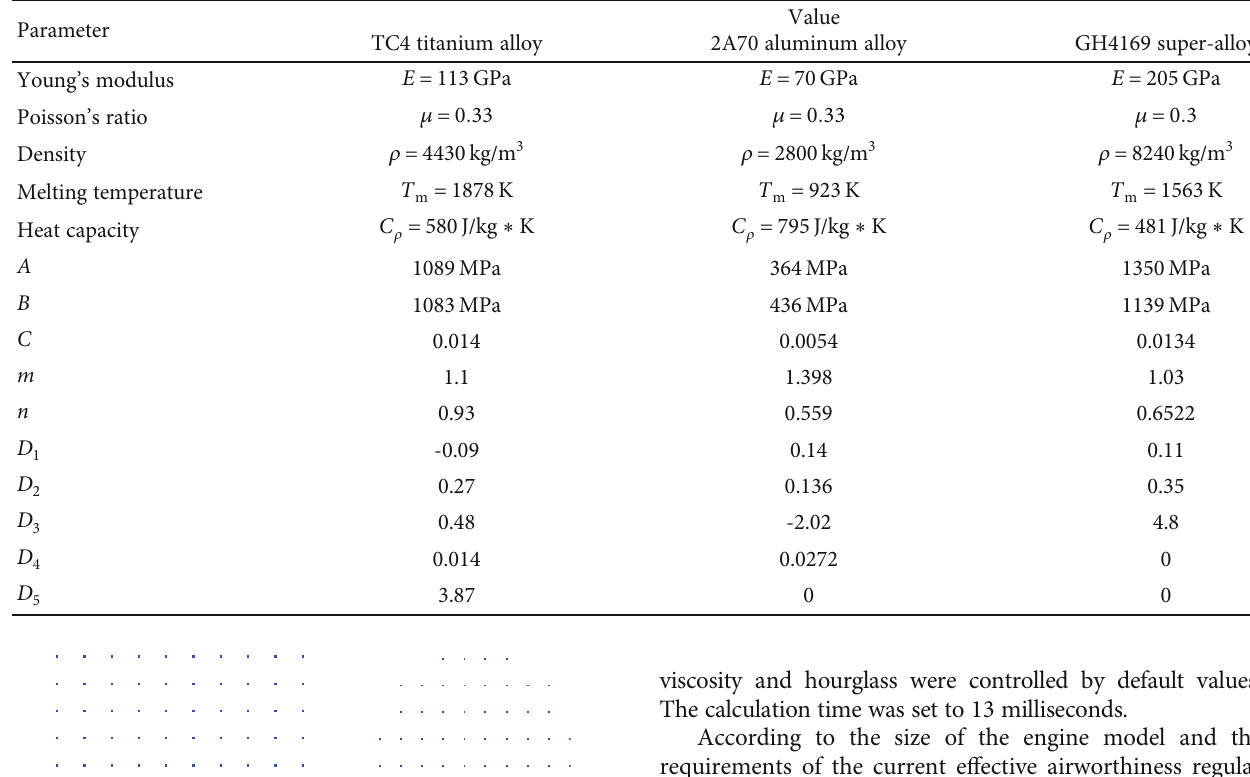
Table 3: Major parameters of Johnson-Cook material constitutive model.